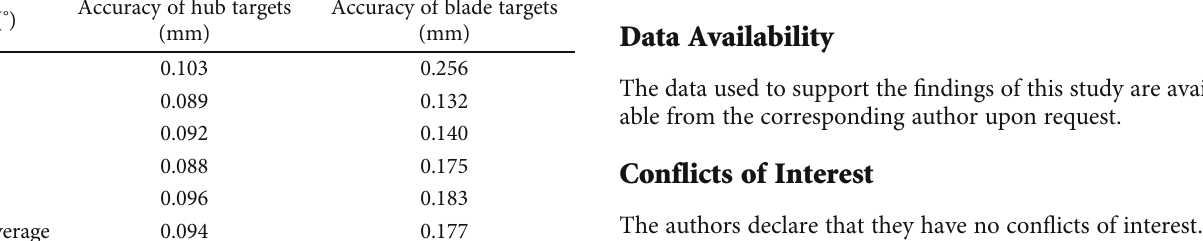
Table 3: Measurement accuracy in forward fl ight. α ( ° ) Accuracy of hub